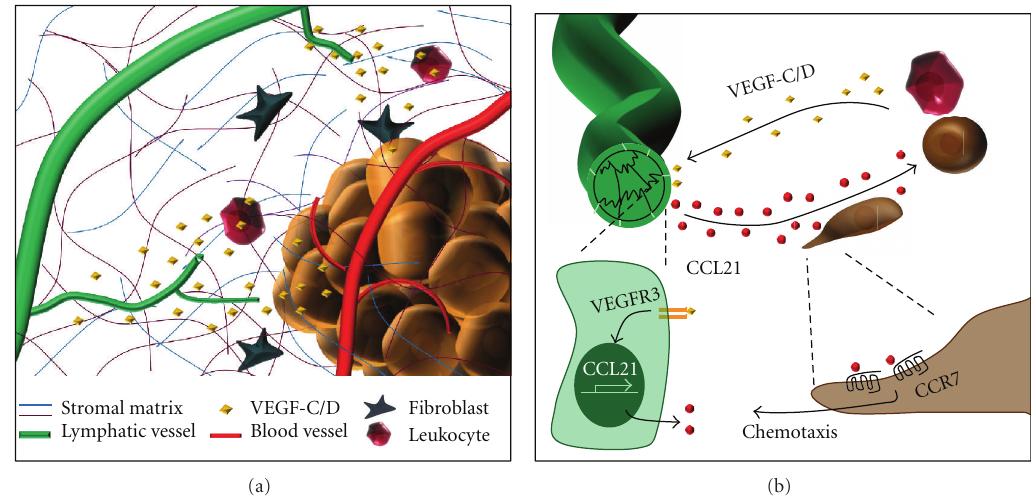
Figure 2: Local paracrine signaling controls lymphangiogenesis and lymph node metastasis. (a) Release of growth factors such as VEGF-C and VEGF-D by tumor and stromal cells promotes lymphatic endothelial cell sprouting, invasion, and capillary tube formation. (b) VEGF-C stimulates lymphatic endothelial cells to produce the chemokine CCL21. Expression of the CCL21 receptor on leukocytes and some tumor cells stimulates chemotaxis toward the lymphatic vessel promoting lymphatic